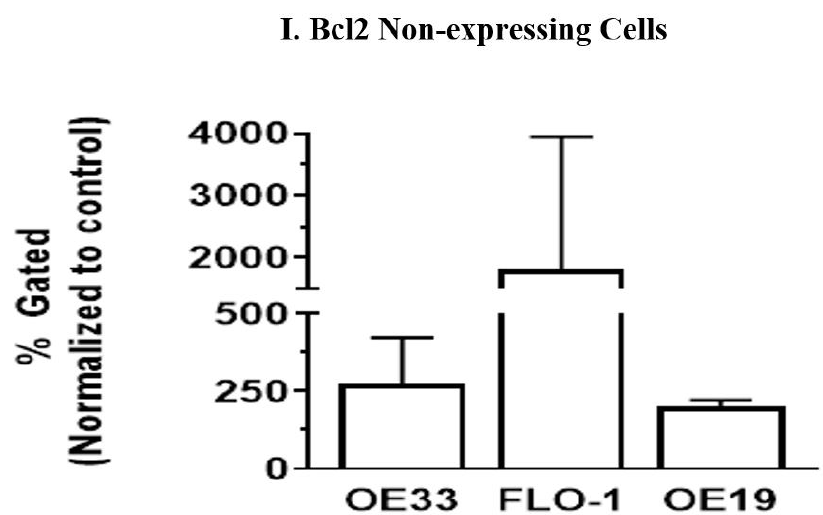
Figure 5. Impact on Bcl2 levels in resveratrol-treated esophageal adenocarcinoma (OE33, OE19 and FLO-1) cells. OE33 cells were grown in 12-well plates; 62,500 cells/well were seeded and they were treated with resveratrol at 100 µ M for 72 h. Three independent experiments were performed. ( A ) Representative scatter plot from Muse Bcl2 dual activation assay of the control group. ( B ) Representative scatter plot from Muse Bcl2 dual activation assay of the treated OE33 group. For OE19 cells, the experiments were similar to OE33, but the resveratrol concentration was 50 µ M (IC 50 concentration). ( C ) Representative scatter plot from Muse Bcl2 dual activation assay of the control OE19 group. ( D ) Representative scatter plot from Muse Bcl2 dual activation assay of the treated OE19 group. FLO-1 cells were treated similar to the OE33 and OE19 cells, except the resveratrol concentration used was 40 µ M (IC 50 concentration). ( E ) Representative scatter plot from Muse Bcl2 dual activation assay of the control FLO-1 group. ( F ) Representative scatter plot from Muse Bcl2 dual activation assay of the treated FLO-1 group. On normalizing to the control group of each cell line, the Bcl2 levels in each cell line are shown by the bar diagram. ( G ) Bar graphs represent activated Bcl2 levels. ( H ) Inactivated molecules of Bcl2, ( I ) Bcl2 non-expressing cells. A one-way ANOVA was used using Dunnett’s multiple comparisons test with the Alpha value set to 0.05. ** indicates adjusted p -values between 0.01 and 0.001.